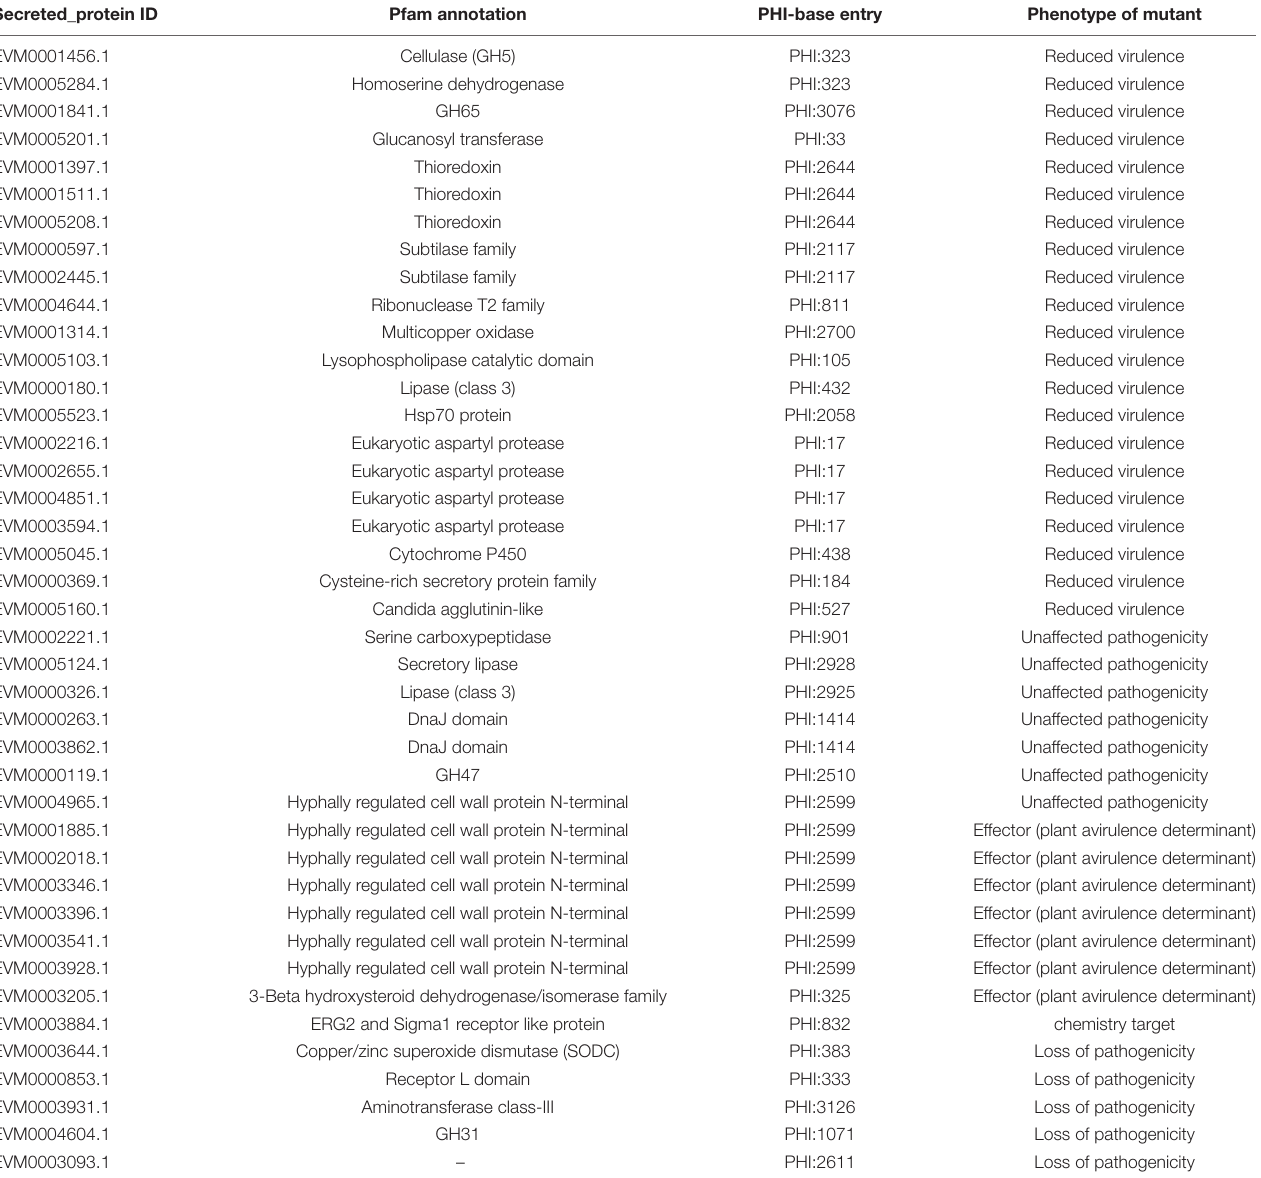
TABLE 3 | Secretory proteins associated with pathogenicity. Secreted_protein